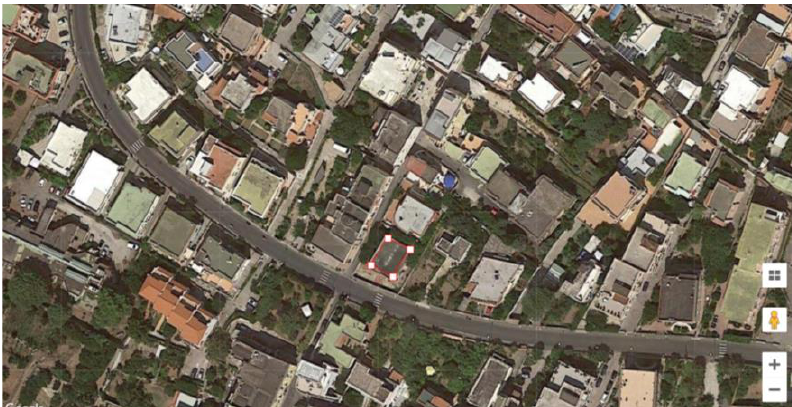
Figure 6. Example of roof surface estimation with PVWatts Calculator tool. It was observed that in Procida, there are different sizes of buildings, according to the zone. This led to dividing buildings into two types, small and large ones, and an average roof dimension was assigned for each type based on observations (see Table 1). Table 1. Types of buildings with associated PV rated power. Type of